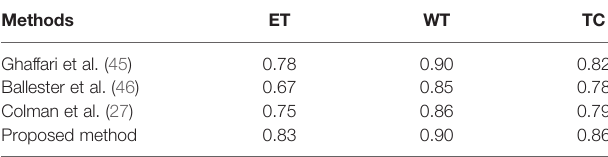
TABLE 3 | Comparison of results of brain tumor